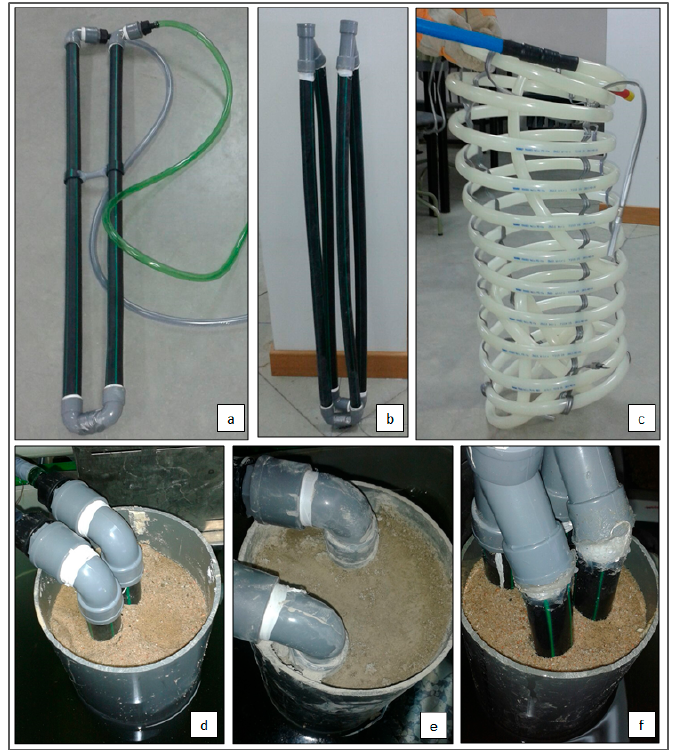
Figure 3. Images of the different configurations tested in laboratory. ( a ) Single U-tube heat exchanger with spacer; ( b ) Double U-tube heat exchanger without spacers; ( c ) Helical-shaped pipe; ( d ) Single U-tube heat exchanger without spacers and grout of saturated sand; ( e ) Single U-tube heat exchanger with spacers and grout of the mixture aluminium cement-sand; ( f ) Double U-tube heat exchanger with spacers and grout of saturated sand.